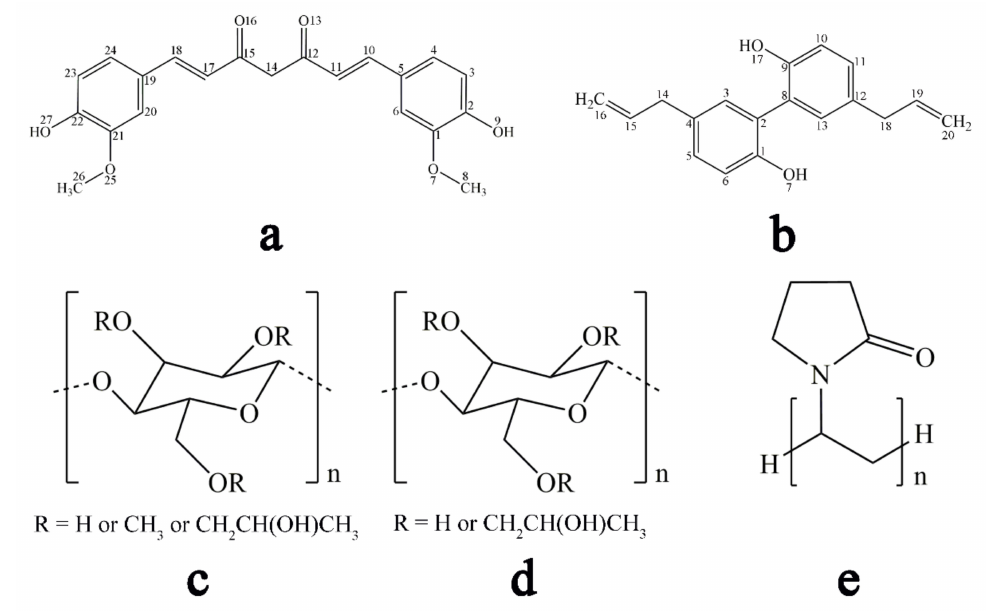
Figure 1. Chemical structures of the model drugs: ( a ) CUR; ( b ) MAG and commonly used polymeric stabilizers; ( c ) HPMC; ( d ) HPC; and ( e ) PVP K30. Whereas, unlike high solubility/dissolution and physical stability of